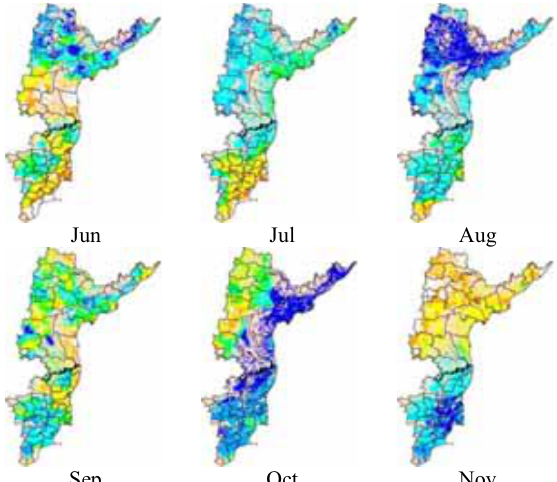
Figure 3: Soil Moisture Index (SMI) of AP and TN at the end of